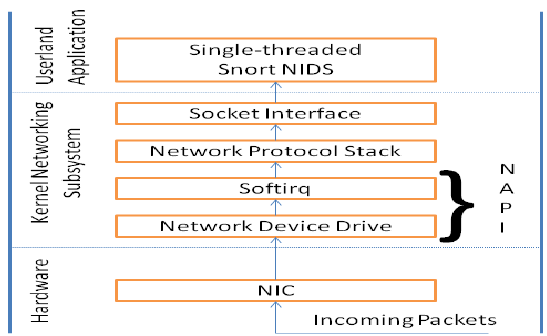
Fig. 2 Snort NIDS underlying kernel support architecture